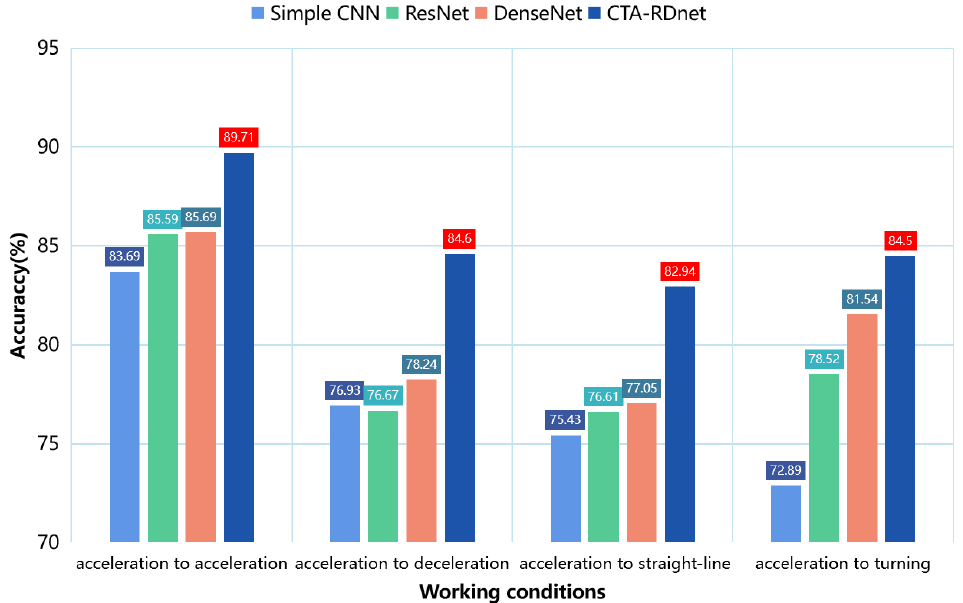
Figure 15. The recognition accuracy of different models under mismatching of working conditions (acceleration).